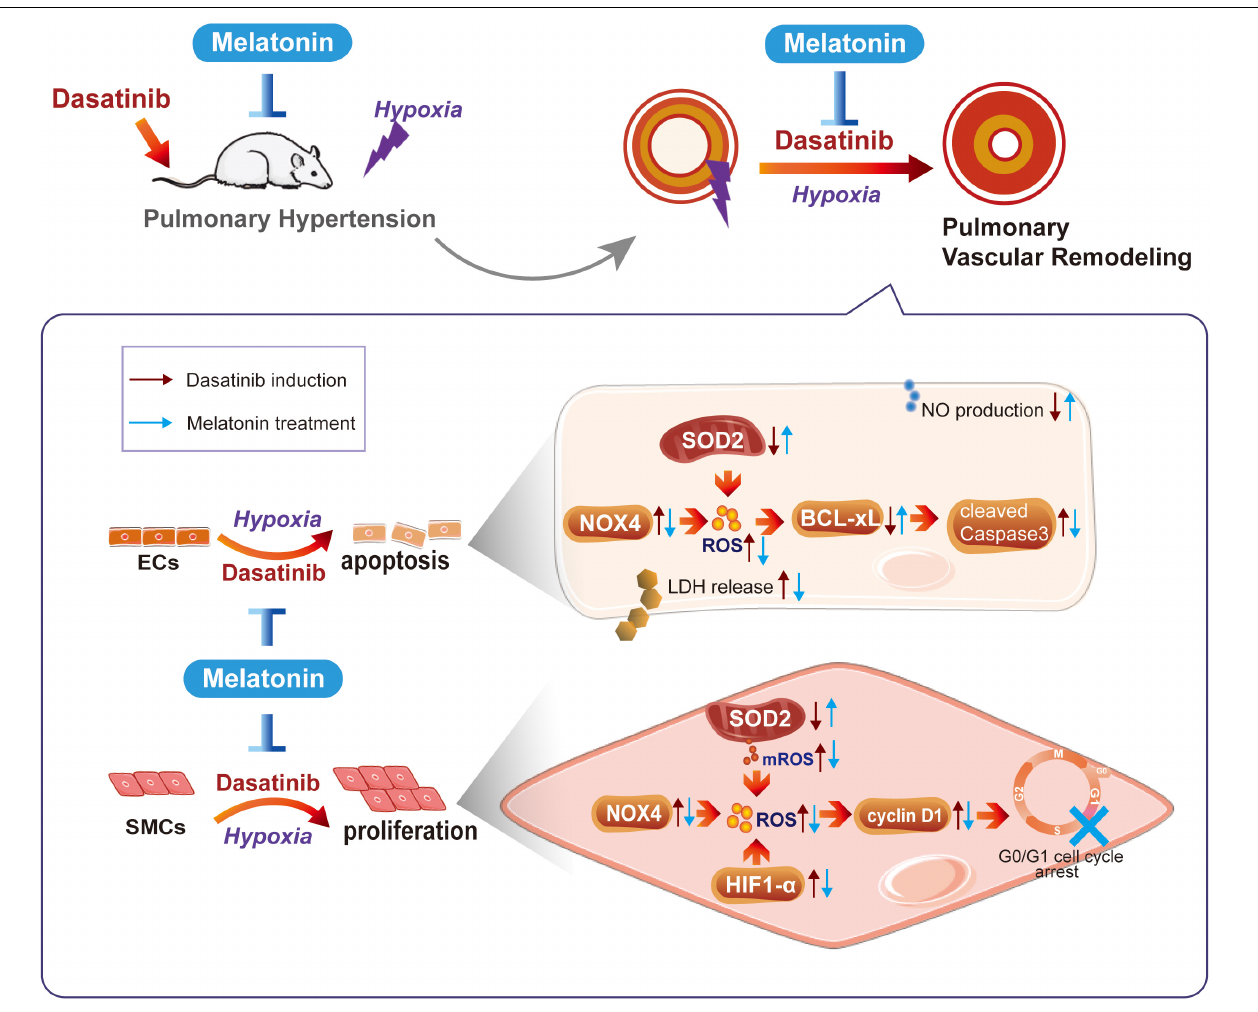
FIGURE 11 | Schematic diagram of this study. Melatonin attenuates dasatinib-aggravated hypoxic pulmonary hypertension via inhibiting pulmonary vascular